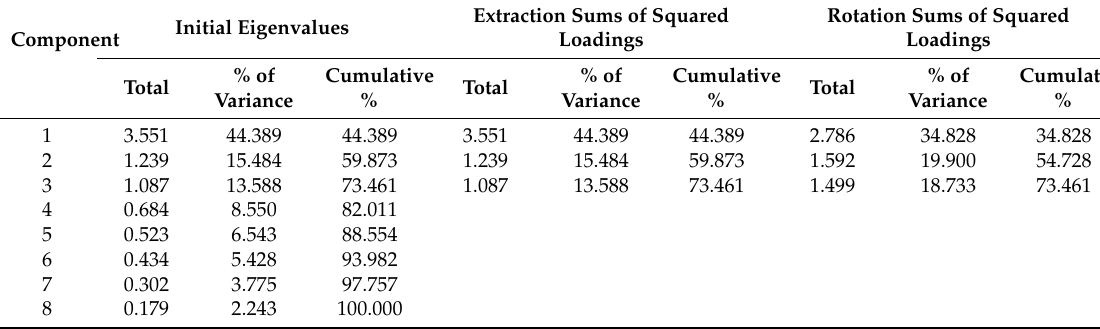
Table 13. Total variance explained.